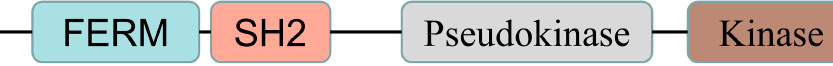
Figure 1. The structure of JAK. Schematic illustrating the four functional domains of JAK, FERM, SH2, pseudokinase, and Kinase. Figure prepared using information from various sources [20,21]. There are seven members of the STAT family in mammals, including STAT1, STAT2,